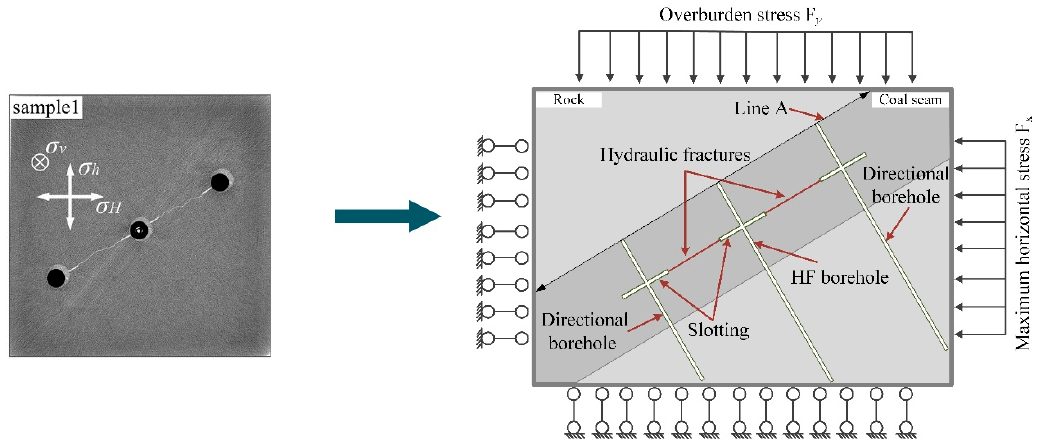
Figure 3. The geometry of the model used for numerical simulation (CT) graph adapted from [11]).